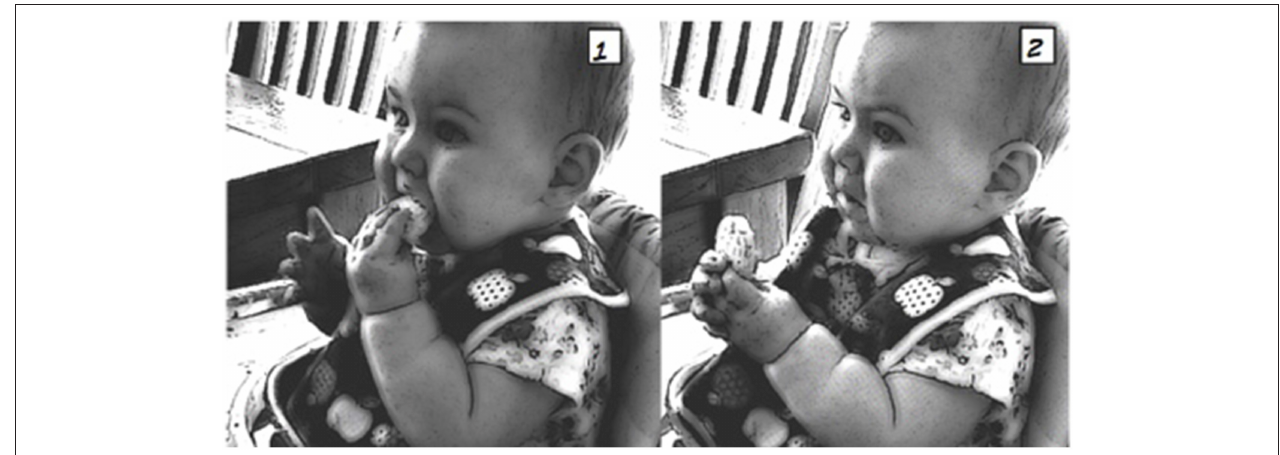
FIGURE 6 | Image published with the written informed consent of the parents of the depicted